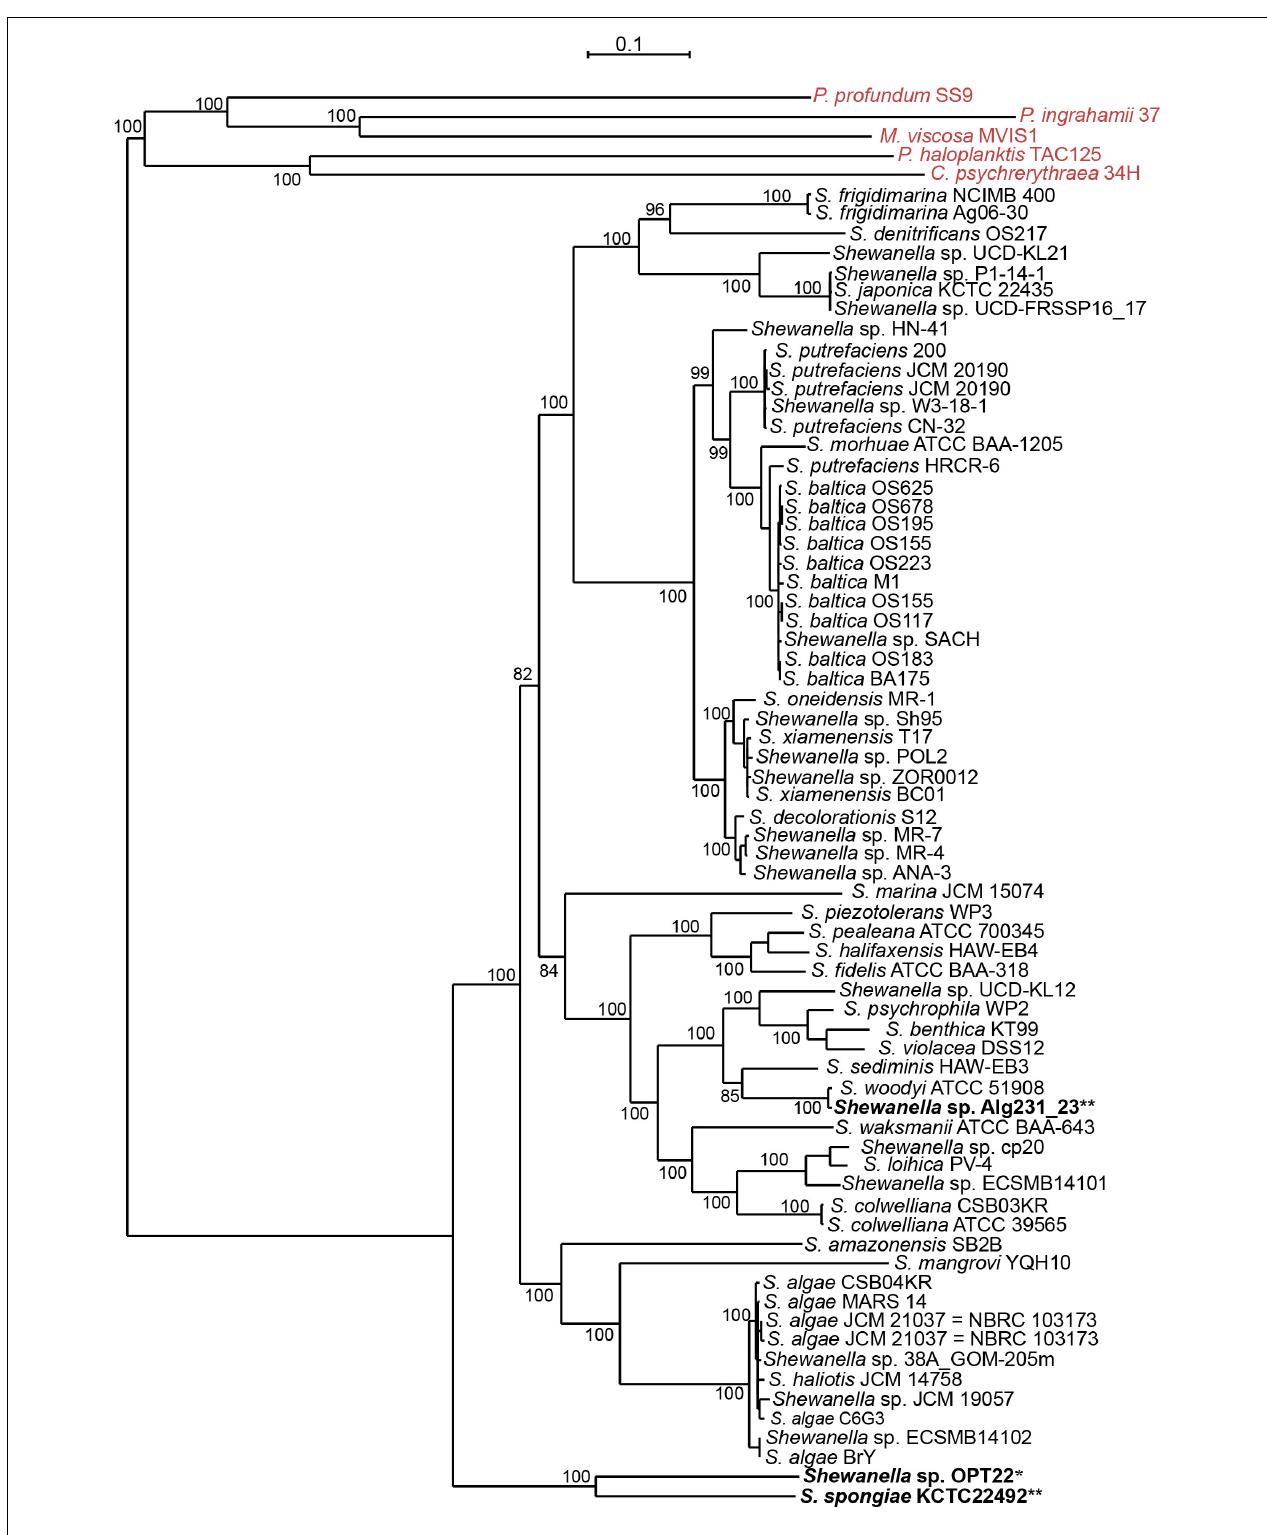
FIGURE 2 | Whole-genome phylogeny of the genus Shewanella . A maximum likelihood tree was inferred from a concatenated protein dataset of 114 single-copy orthologous genes. Strains in bold denote the only available genomes of sponge-associated Shewanella that are used in this study. The genomes of the Shewanella strains sequenced here and from previous studies are shown as single and double asterisks, respectively. Outgroup species are labeled in red. Bootstrap node support values above 80 are shown.